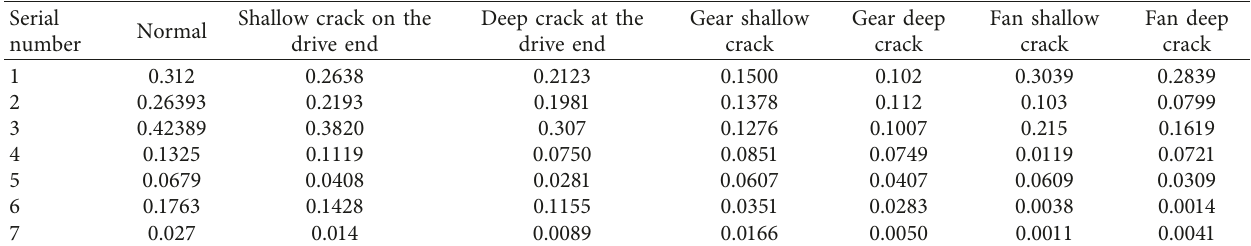
Table 7: The energy distribution of the third category example failure mode (drive end, fan, and gear).